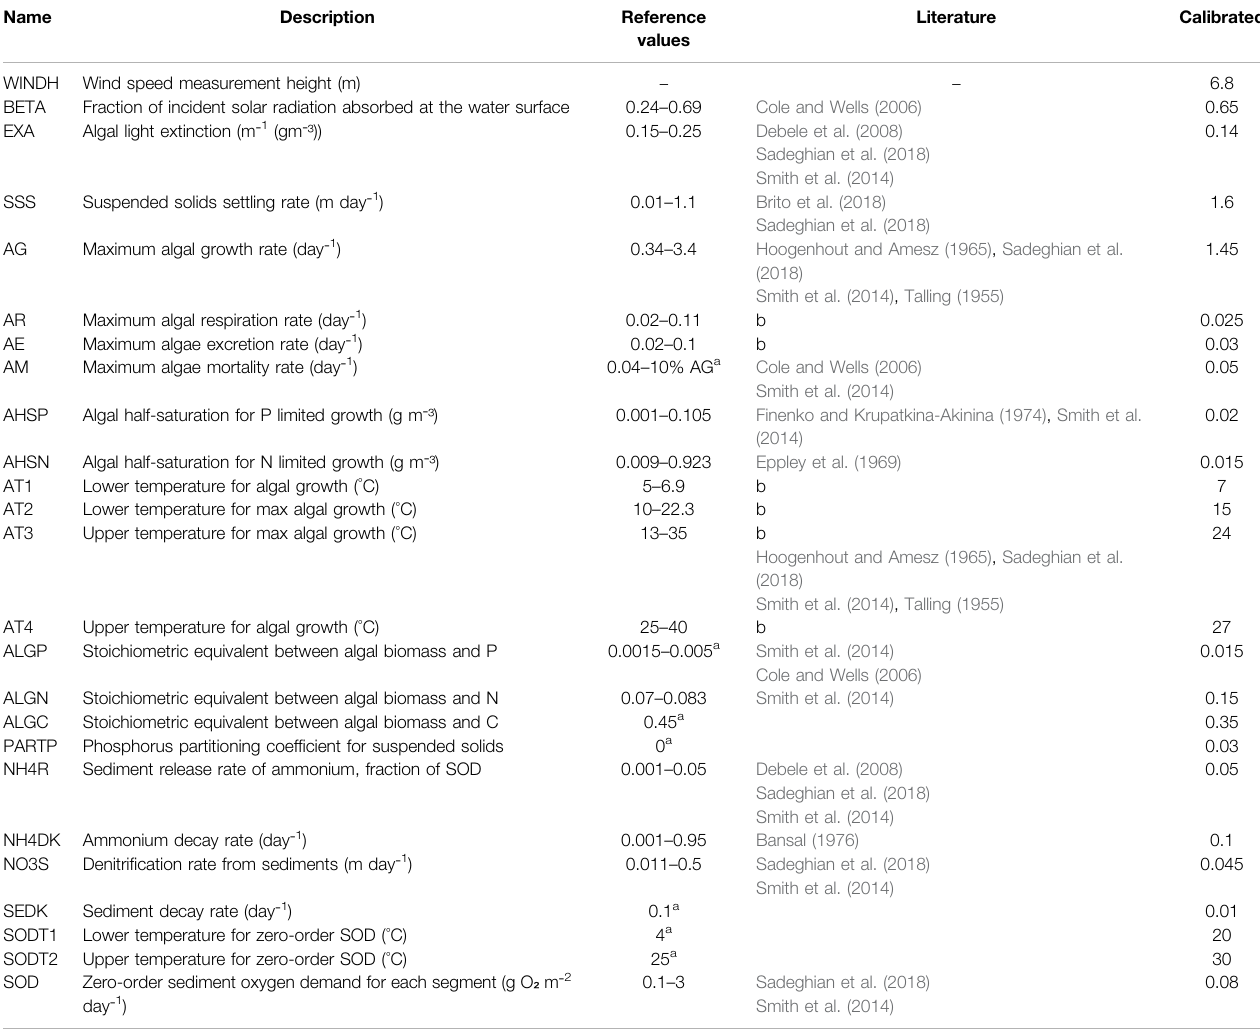
TABLE 1 | Control fi le parameters literature ranges and fi nal calibrated